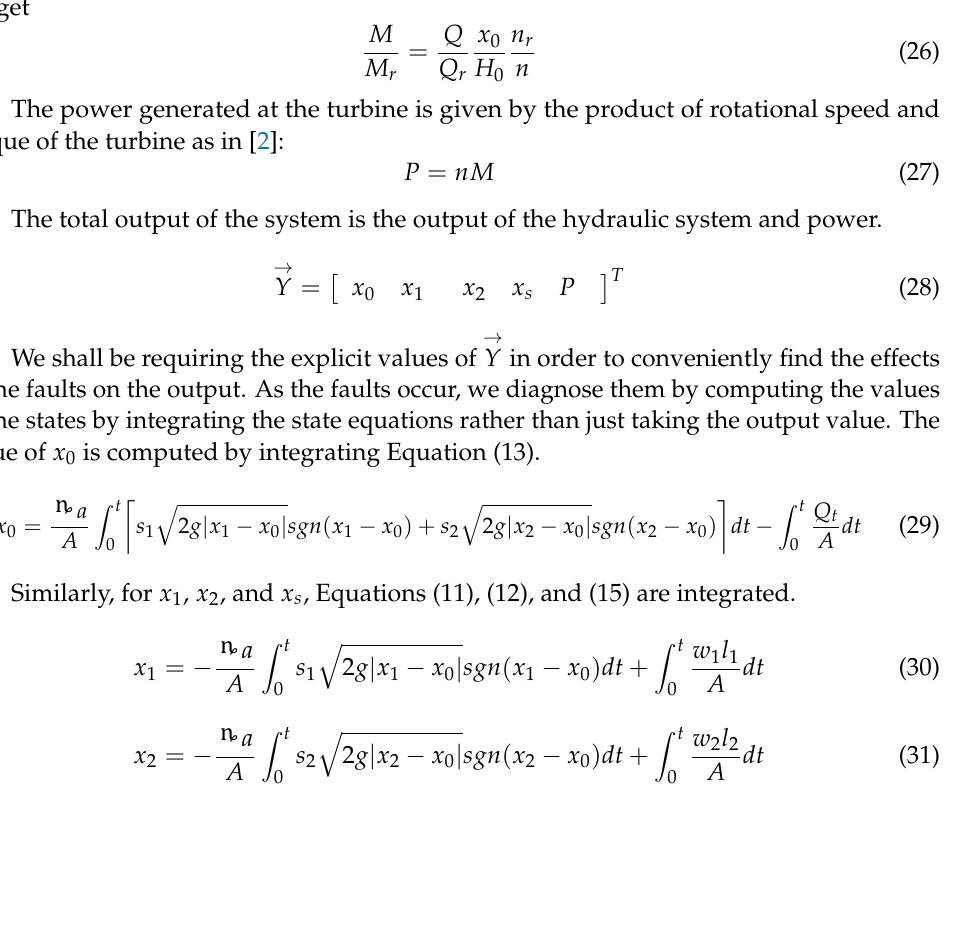
Figure 1. Three-pond hydraulic system.